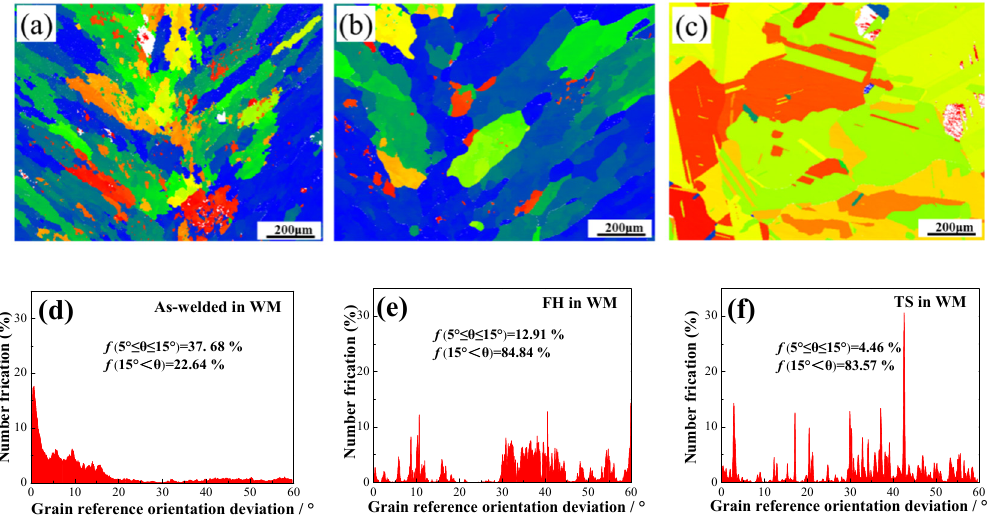
Figure 5. Grain reference orientation deviation (GROD) mapping of the weld metal for the as-welded ( a , d ), FH ( b , e ), and TS ( c , f ) samples. The WM recrystallized grain analysis of the as-welded and heat-treated samples was carried out to make clear the evolution of the microstructure during the thermal shock process, as shown in Figure 6. The WM of the as-welded and FH samples are mainly comprised of sub-grains with small recrystallized grains, as shown in Figure 6a,b. However, the TS samples were mainly comprised of recrystallized grains (77%). This phenomenon supports the hypothesis that the AGG was generated by recrystallization in the thermal shock process.